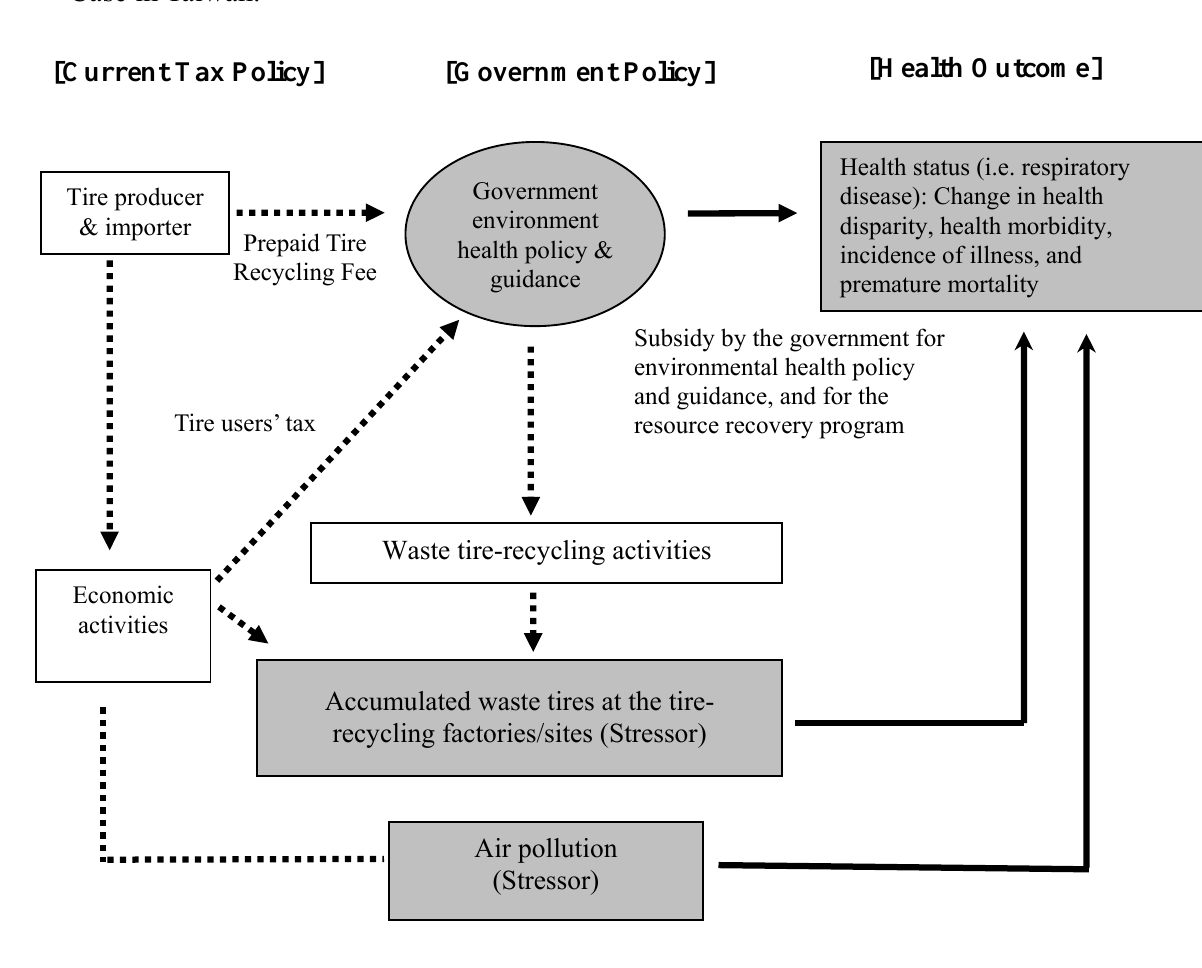
Figure 2. Flowchart of Environmental Health Policy and Resource Recovery Program: A Case in